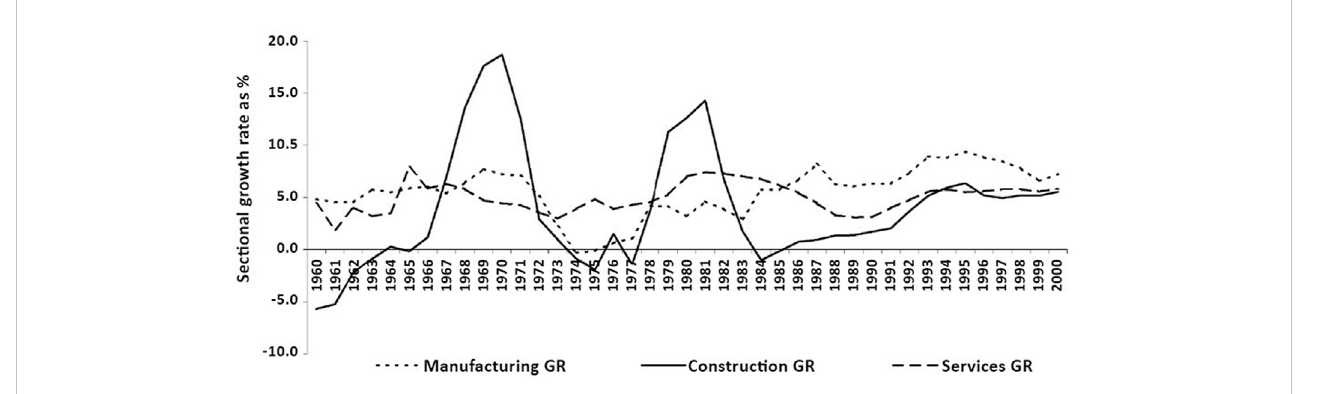
FIGURE 2 The trend of sectoral growth rate in Sri Lanka from 1960 to 2000 (Rameezdeen et al.,